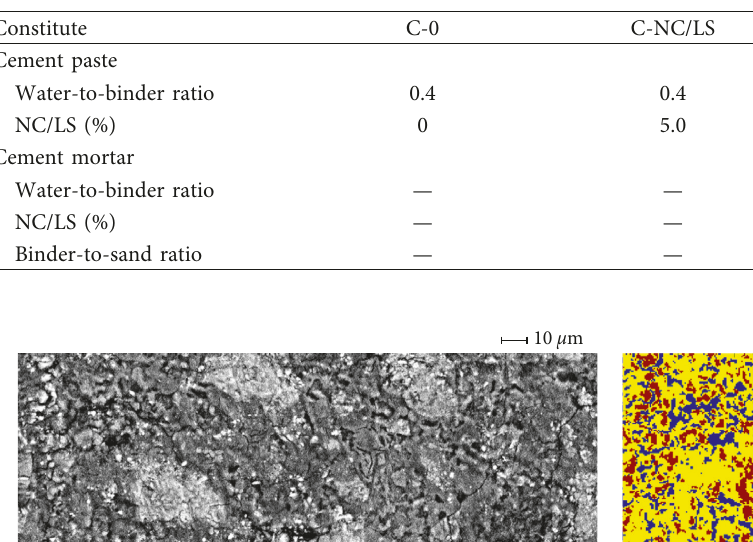
Table 2: Proportions of cement paste and mortar.